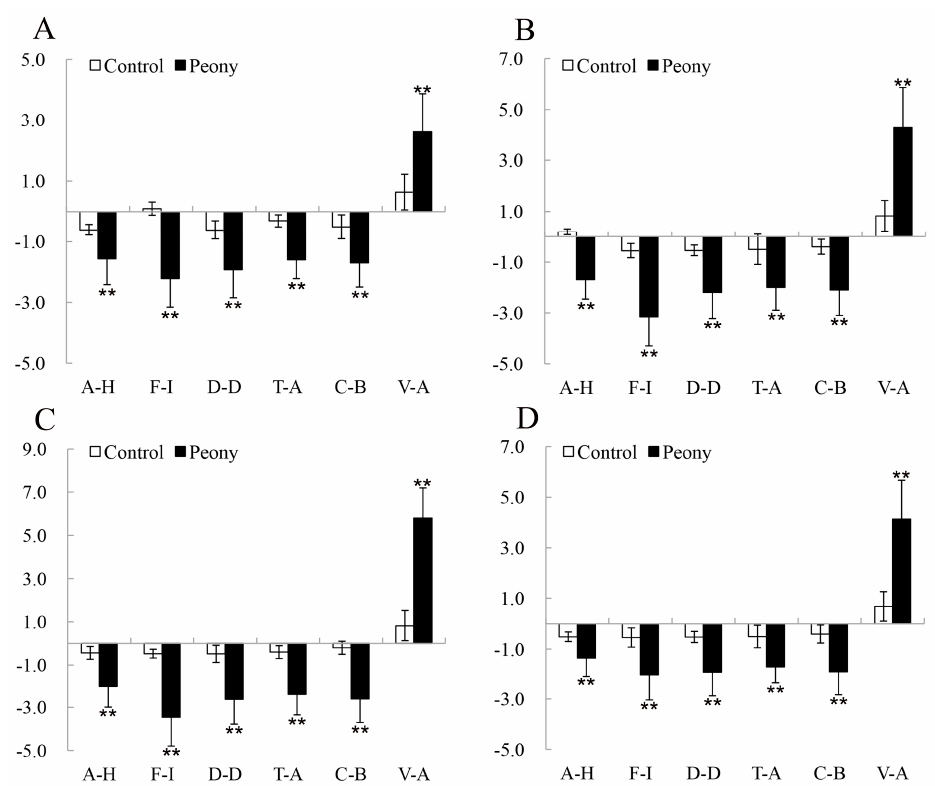
Figure 7. The pre- and post-viewing changes of POMS scores during the experimental (peony) and control groups in the ( A ) ELS (exhibition leaf stage), ( B ) IBS (initial bloom stage), ( C ) FBS (full bloom stage), and ( D ) TBS (terminal bloom stage). A–H: anger–hostility, F–I: fatigue–inertia, D–D: depression–dejection, T–A: tension–anxiety, C–B: confusion–bewilderment, and V–A: vigor–activity. N = 74, mean ± SD. ** p < 0.01, paired-sample t- test.